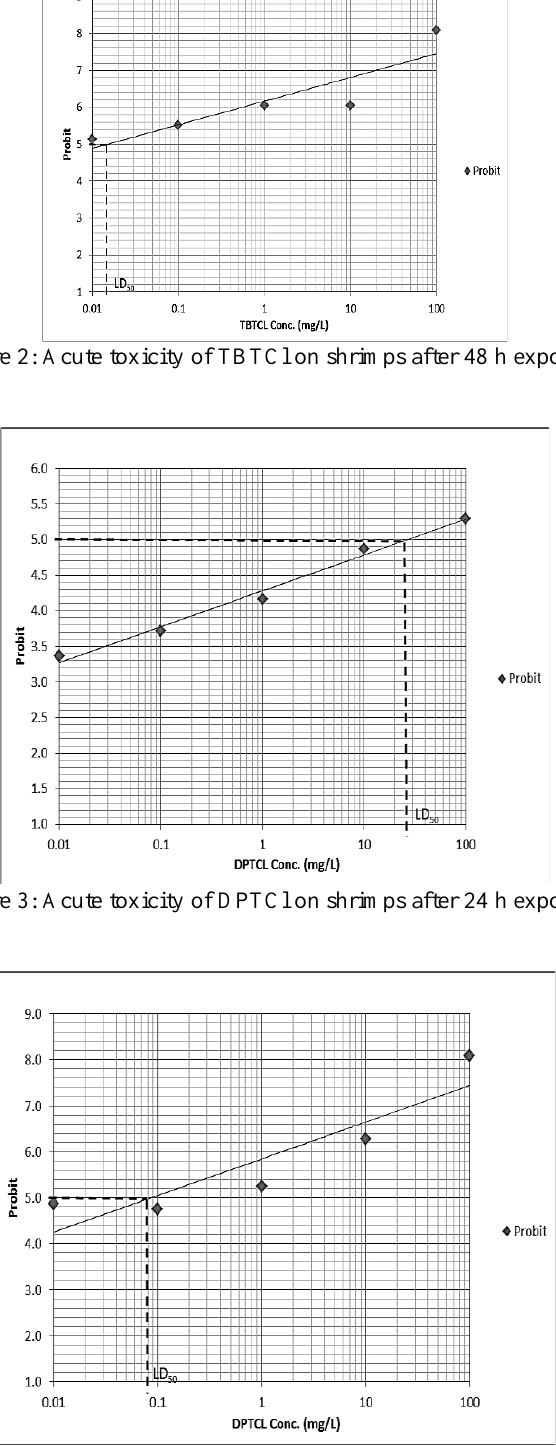
Figure 4: Acute toxicity of DPTCl on shrimps after 48 h